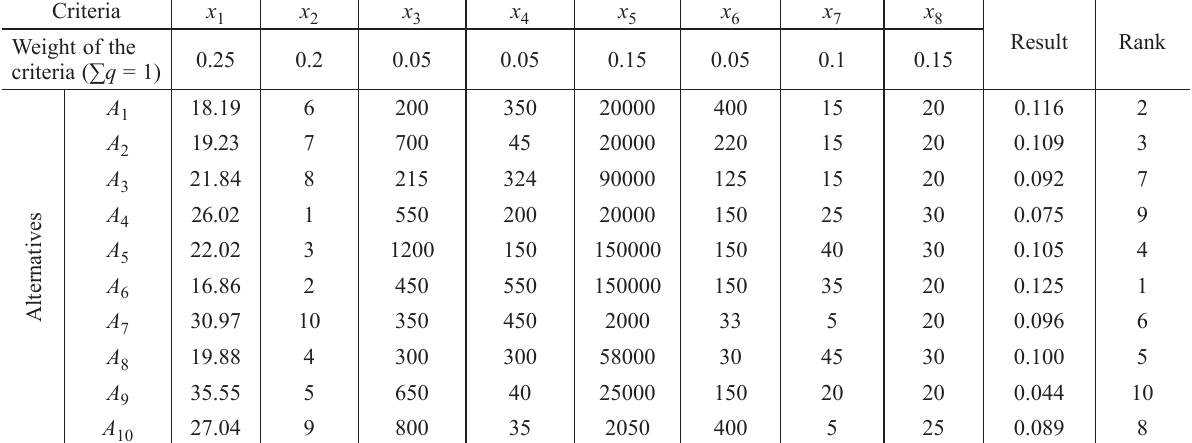
Table 3. The decision matrix of the final data obtained following the Hurwicz rule